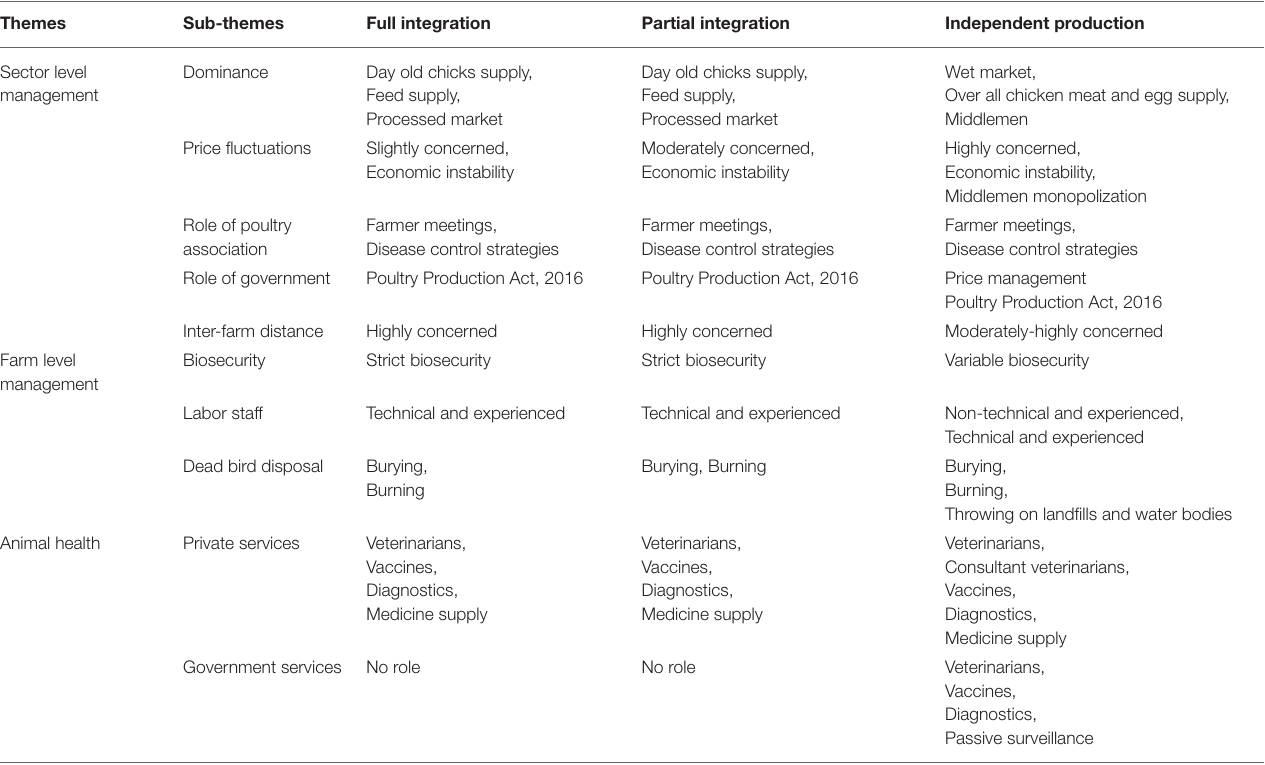
TABLE 3 | Major themes identified regarding management and health services by production system.